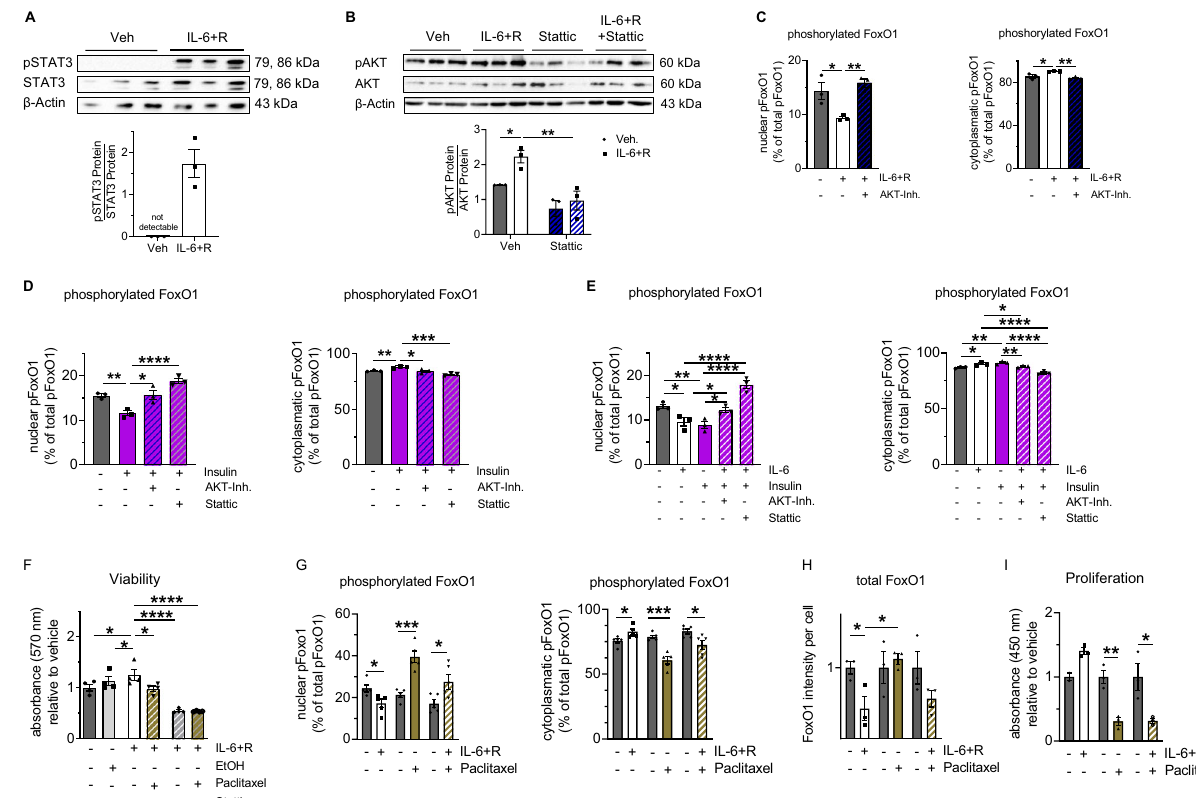
Fig. 6 Interleukin (IL) − 6 regulates the proliferation of human bronchial smooth muscle cells (hbSMC) via FoxO1. For the experiments with STAT3- inhibitor (Stattic) and AKT inhibitor (AKT-Inh.), hbSMC were pre-exposed to either Stattic, AKT-Inh. or vehicle for 2 h. Subsequently, the hbSMC were stimulated as indicated. A Immunoblot showing phosphorylated STAT3 (pSTAT3) in hbSMC after exposure to IL-6 with soluble IL-6 receptor (IL-6 + R) or